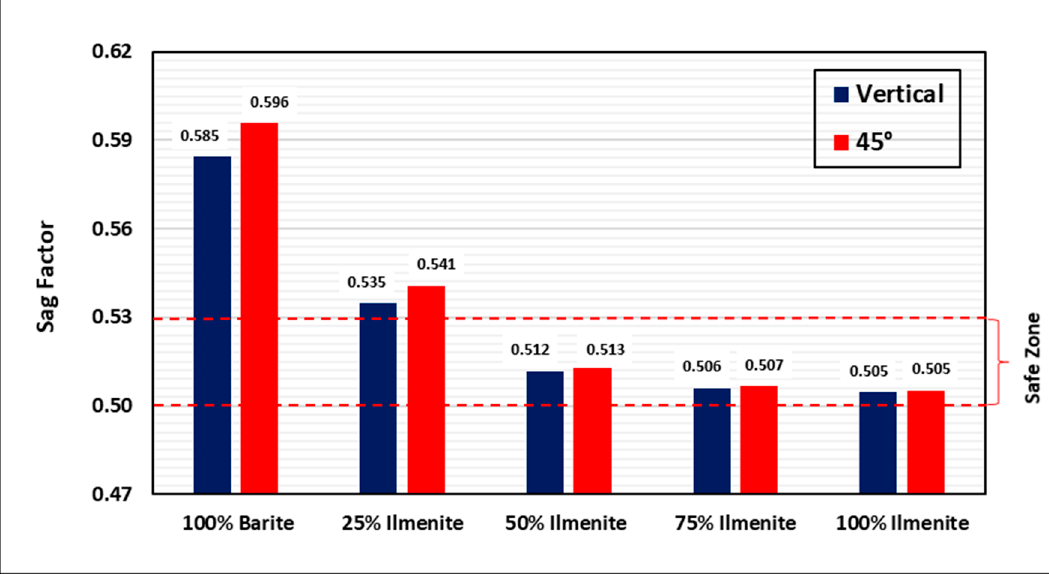
Figure 8. Effect of ilmenite on ( a ) plastic viscosity, and ( b ) yield point. Figure 9. Effect of ilmenite on gel strength at (a) 120 °F, and (b) 250 °F.